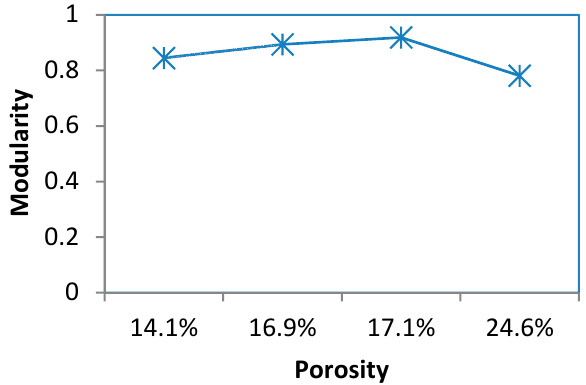
Figure 3. Sandstone pore network modularity.